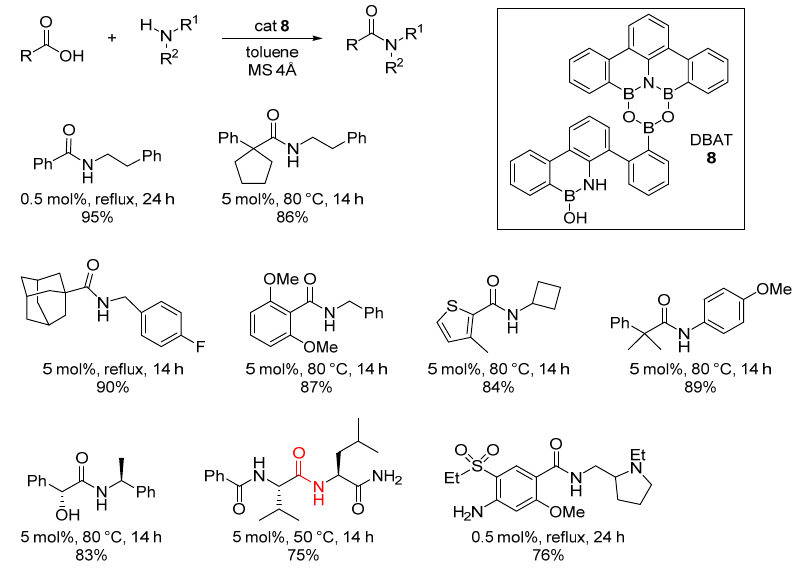
Scheme 7. DTAB 8 catalyzed